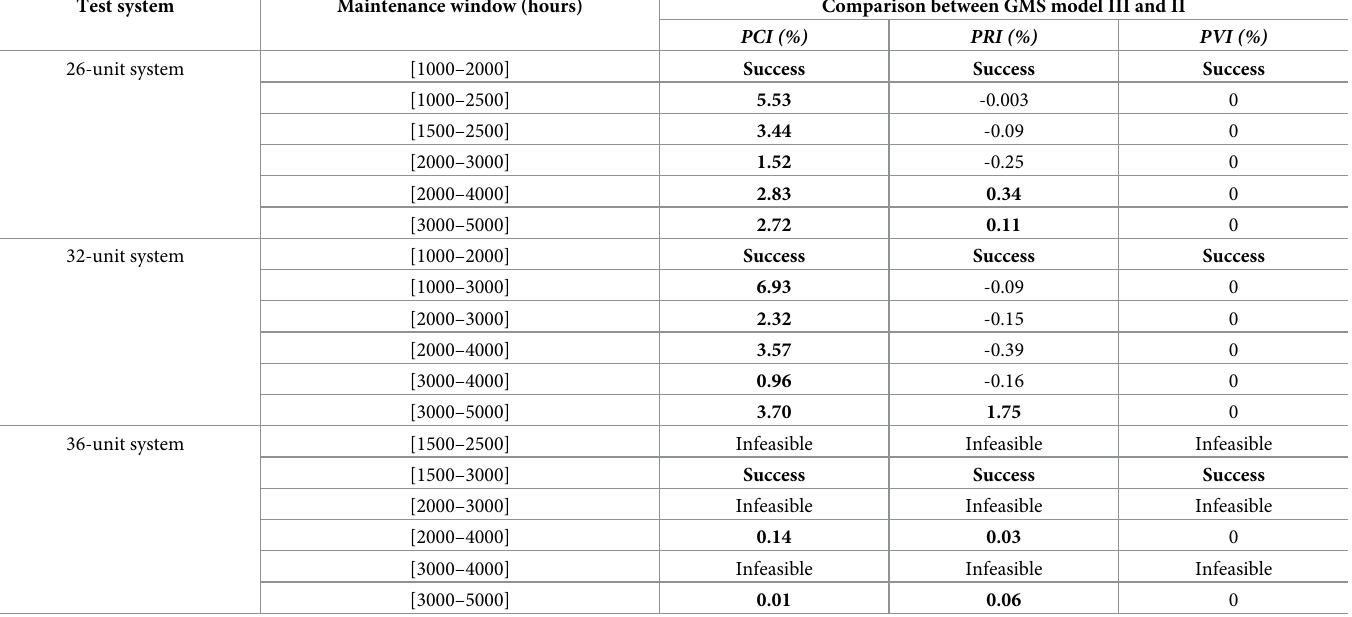
Table 12. Percentage of cost, gross reserve, and violation improvements between GMS model III and GMS model II. Test